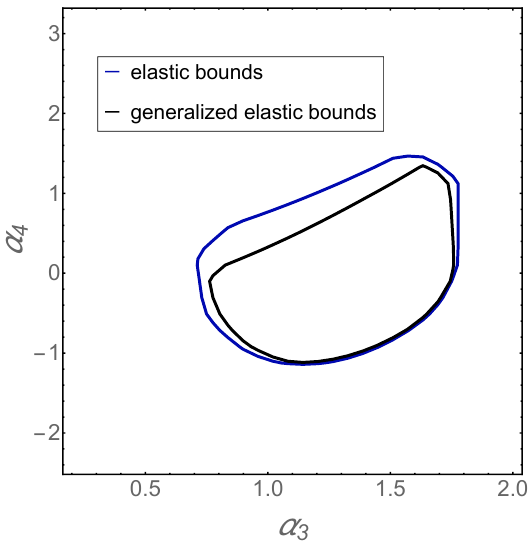
Figure 9 . (Line theory) Positive regions in the ( α 3 , α 4 )-plane. The region within the solid blue line is allowed by the usual elastic bounds from scattering hh → hh , ff → ff and hf → hf , while the black line is obtained by using the generalized elastic bounds. Here we choose ˜ x = ˜ m γ = M 1 /M 2 = 1 (or equivalently θ = 0 . 1 ), β 3 = 1 and β 4 = 0